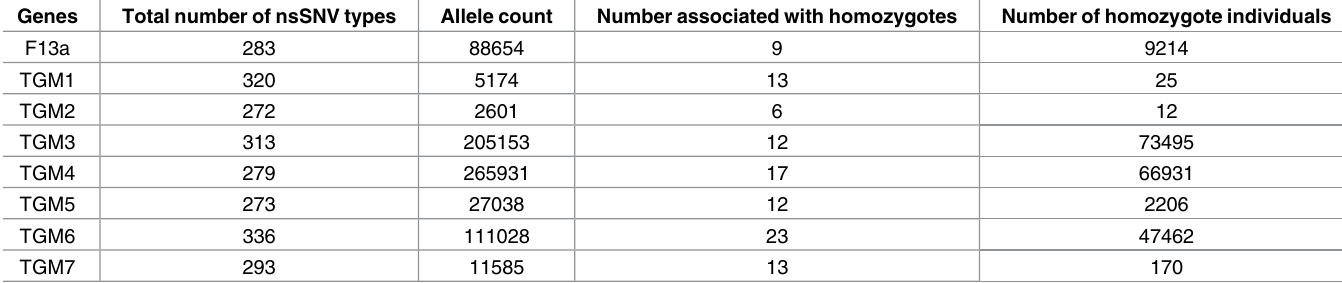
Column 2 shows the total number of nsSNVs; column 3 has the observed allele counts for the nsSNVs; column 4 presents the number of nsSNVs associated with homozygotes; column 5 contains the number of homozygote